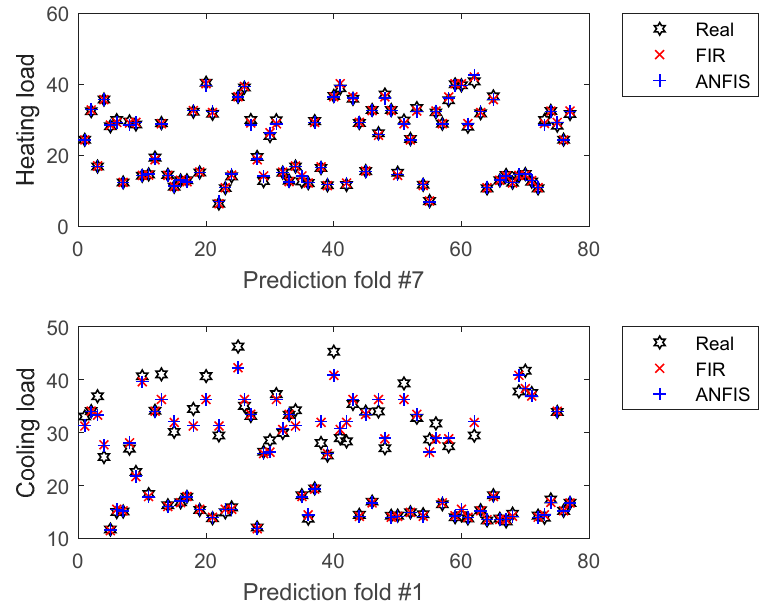
Figure 10. Real versus ANFIS and FIR prediction results for heating load (upper plot) and cooling load (lower plot) models. Each point in the plot represents a building. The results of the Cooling Load correspond to fold #1 in one of the 10 iterations. MAE and RMSE obtained by the ANFIS model in this fold are 1.08 and 1.76, respectively. MAE and RMSE obtained by the FIR model in this fold are 1.16 and 1.74, respectively. The results of the Heating Load correspond to fold #7 in one of the 10 iterations. MAE and RMSE obtained by the ANFIS model in this fold are 0.54 and 0.68, respectively. MAE and RMSE obtained by the FIR model in this fold are 0.42 and 0.61, respectively.